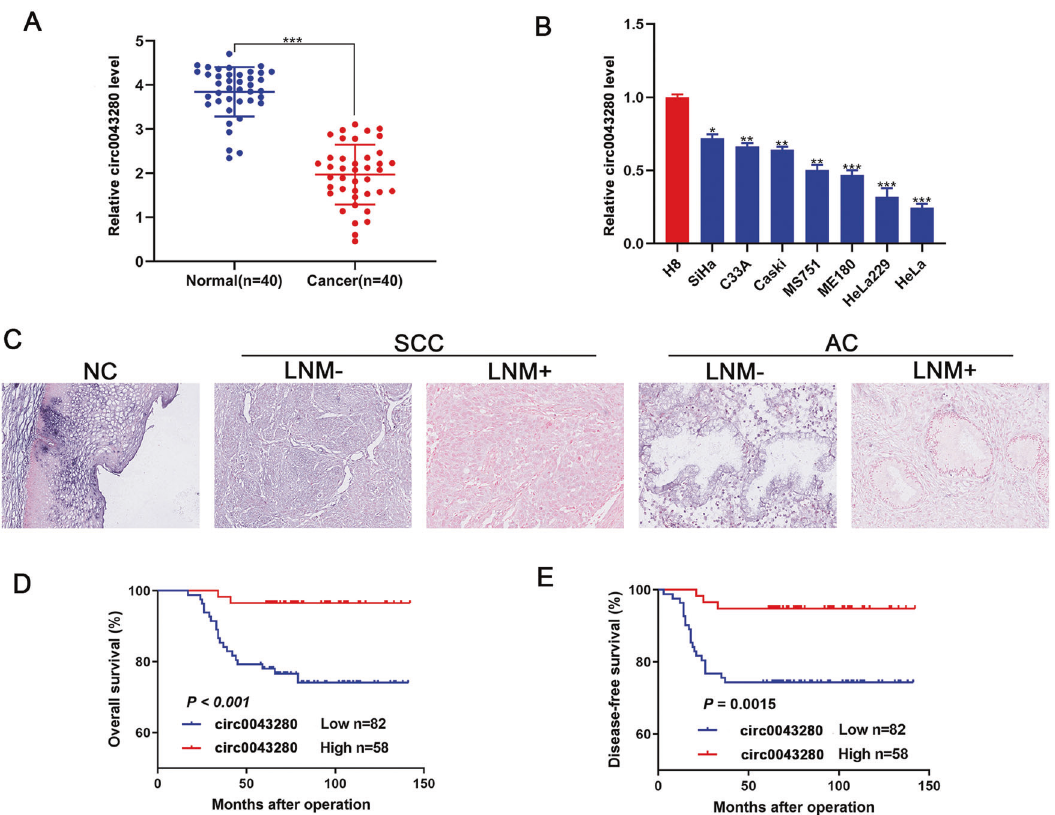
Fig. 2 The downregulated expression of hsa_circ_0043280 was associated with a poor prognosis in patients with CCa. A Expression levels of hsa_circ_0043280 in CCa tissues in comparison with matched normal tissues were measured using qRT-PCR. B qRT-PCR analysis of hsa_circ_0043280 expression in CCa cell lines and a normal cervical cell line H8. C ISH analysis of hsa_circ_0043280 in specimens of normal uterine cervical tissues, cervical cancers with lymph node metastasis, and cervical cancers without lymph node metastasis. Original magni fi cation: × 100. Kaplan – Meier survival curves showed poor overall survival ( D ) and disease-free survival ( E ) with low expression levels of hsa_circ_0043280. Each experiment was performed at least three times independently. * P < 0.05; ** P < 0.01; *** P <